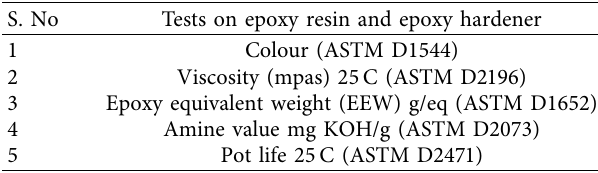
Table 6: Tests on epoxy resin and epoxy hardener. S.